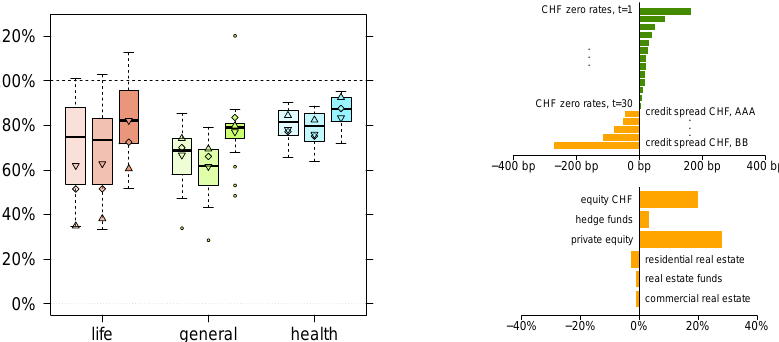
Figure 10. (lhs) illustrates the impact ratios (cid:36) i for the real estate market crash scenario (left plots), see Figure 7, together with declined new business and increased lapse rates ( first cascade effect ) (middle plots) and together with the market impacted triggered by the sale of assets ( second cascade effect ) (right plots). (rhs) illustrates the changes in market risk factors corresponding to the market impact. The changes colored green are caused by the price impact, the changes colored orange result from market